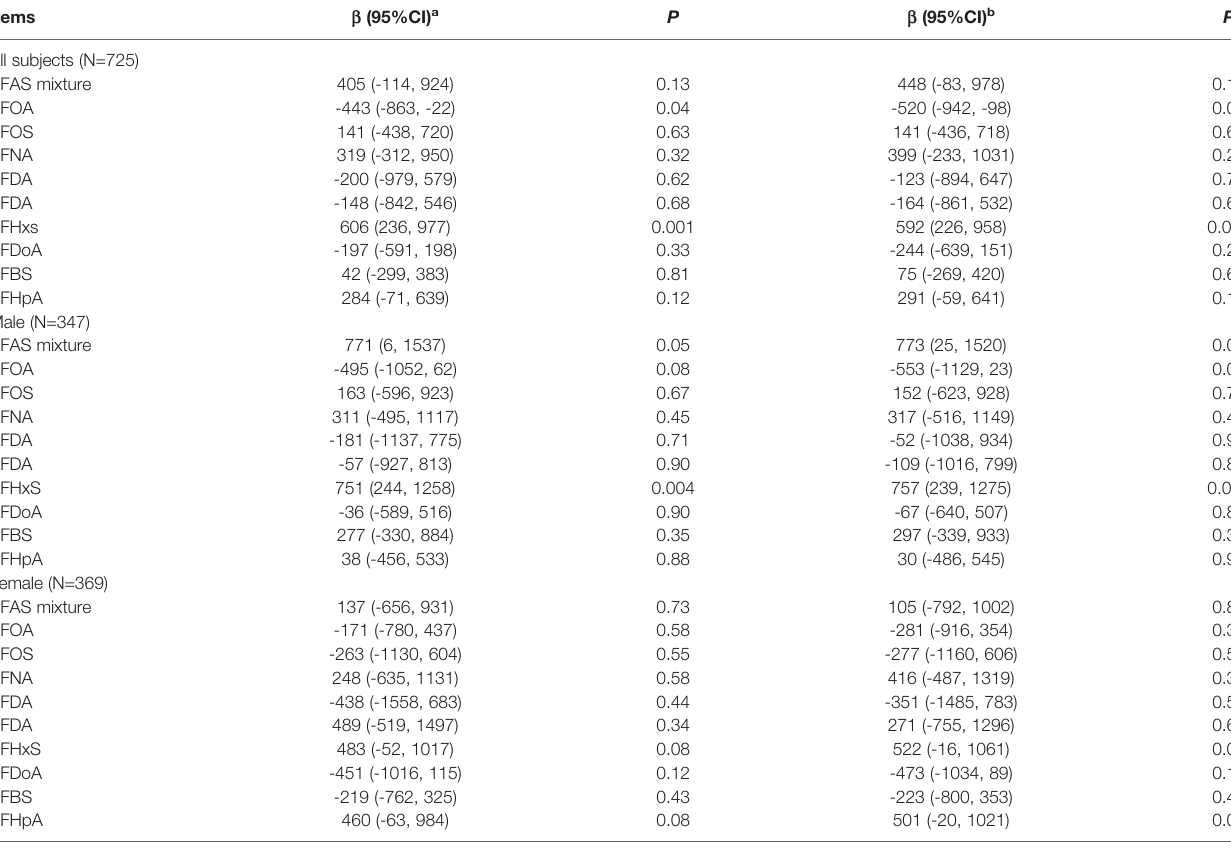
TABLE 4 | The total effect of exposure mixture and independent effect of individual PFAS after controlling for other exposure items on BNDF levels in cord blood * . Items b (95%CI) a P b (95%CI) b